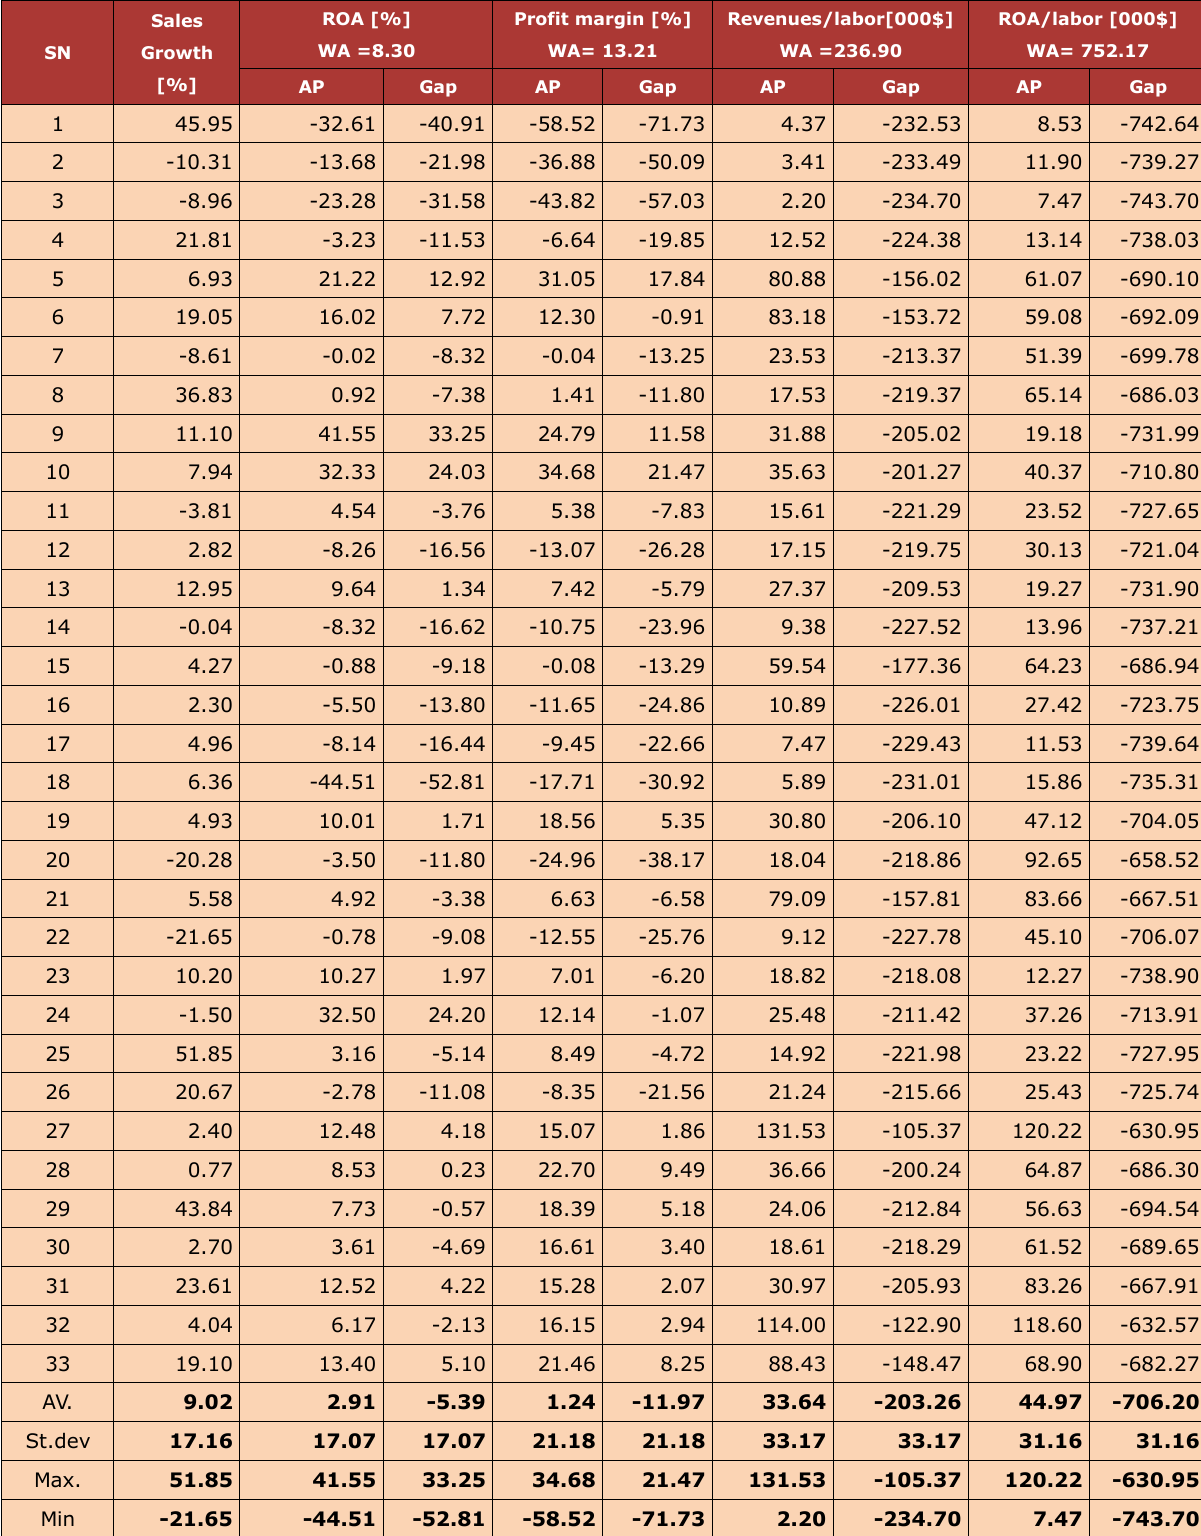
Table 6. Summary of companies’ business performance. Researchers’ computation from survey results, and sources for global norms: Philip M. Parker, Professor, INSEAD, and copyright 2003 cited